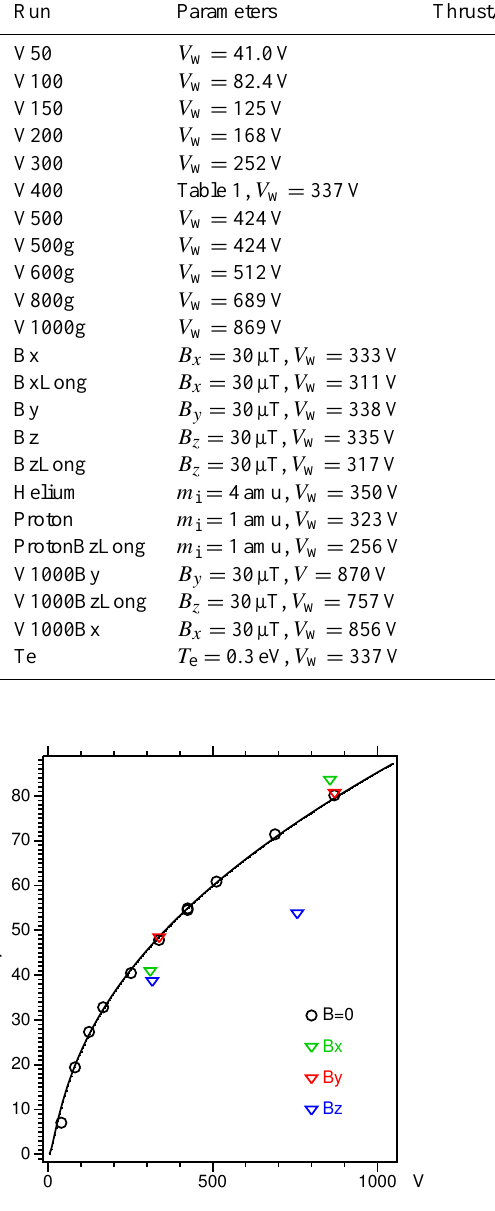
Figure 1. Different marks: thrust as function of tether voltage V w in oxygen plasma with and without magnetic field, see legend in plot and Table 2 for run parameters. Solid line: Eq.